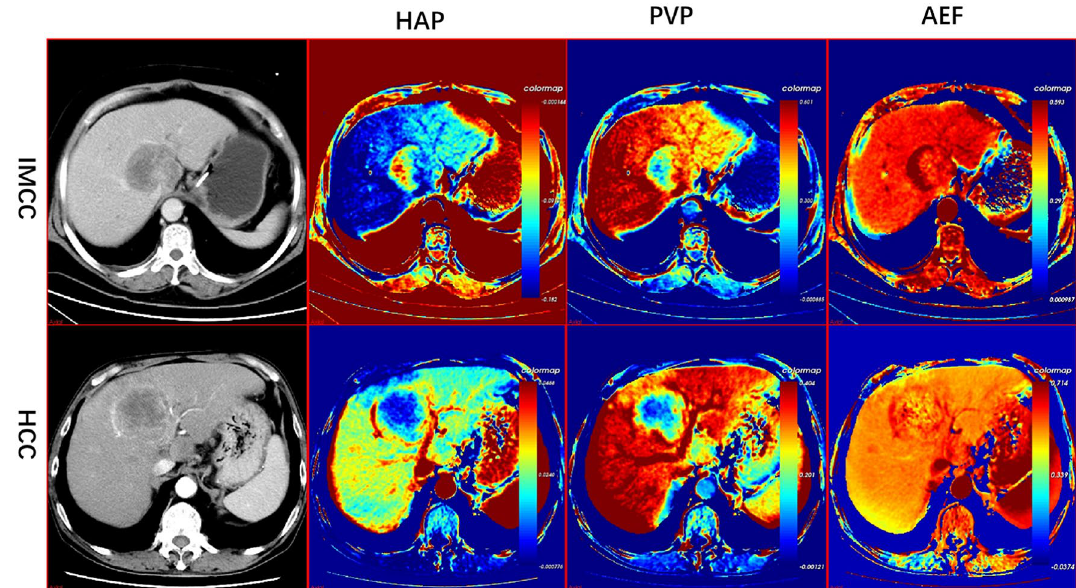
Figure 2. Traditional enhancement image and pharmacokinetic images of IMCC and HCC. For the patients with IMCC, the HAP image showed high perfusion in the margin and relatively low perfusion in the center. PVP images showed hyperperfusion from the peripheral to the central part of the tumor. For patients with HCC, the HAP image showed high perfusion in the rim, while the PVP image showed homogeneous low perfusion in the complete lesion. The AEF images both showed heterogeneous high perfusion for two tumor lesions. HAP Hepatic arterial supply perfusion, PVP Portal venous supply perfusion, AEF Arterial enhancement fraction, IMCC Intrahepatic mass-forming cholangiocarcinoma, HCC Hepatocellular and HCCs are shown in Table 2. Representative CT perfusion images derived from the triphasic CT scans of IMCCs and HCCs are shown in Fig. 2. The AEF mean value, the difference in AEF between tumor and nor- mal liver (ΔAEF = AEF tumor − AEF liver ), and the relative AEF (rAEF = ΔAEF/AEF liver ) were significantly higher in HCCs than in IMCCs ( P ≤ 0.001). The mean value of HAP in patients with HCC was significantly higher than in patients with IMCCs ( P = 0.024). There were no statistical differences in the other perfusion parameters between IMCCs and HCCs ( P > 0.05). The histogram parameters for IMCCs and HCCs are shown in Tables 2 and 3. All of the percentiles of the AEF mean value, ΔAEF, and rAEF were significantly higher in patients with HCCs than with IMCCs ( P < 0.05). The 10th, 25th, 50th, and 75th percentiles of HAP were significantly higher in HCCs than in IMCCs ( P < 0.05). The kurtosis of AEF was higher in patients with HCCs than with IMCCs ( P = 0.033), and the variance of PVP was lower in HCCs than in IMCCs ( P = 0.009). The 25th percentile of HF tumor was significantly higher in patients with HCCs than IMCCs ( P = 0.036). The 10th and 25th percentiles of ∆HF were also higher in HCCs than in IMCCs ( P = 0.011 and 0.030, respectively). For the other histogram parameters, there were no statistically significant differences between the two groups. Differential diagnostic ability of the perfusion parameters and the corresponding histogram parameters for IMCCs and HCCs. ROC curves were used to evaluate the ability of the statistically signifi- cant tumor perfusion parameters and corresponding histogram parameters to discriminate between IMCCs and HCCs. As shown in Figs. 3 and 4, and Table 4, of the mean value of AEF and all corresponding percentiles of the histogram analysis, the 10th percentile of the AEF had the highest value of 0.769. The sensitivity and specificity were also 77.8% and 67.6%, respectively, with a cutoff value of 0.466. The positive predictive value (PPV) and negative predictive value (NPV) were 0.792 and 0.657, respectively. The 25th percentile of the AEF had the high- est sensitivity of85.2%, however, the 50th percentile of the AEF had the highest specificity of70.6%. For the mean value and corresponding percentiles of ΔAEF and rAEF, the 10th percentile of ΔAEF and rAEF had the highest AUC value of 0.788, with the cutoff value of − 0.034 and 0.952, respectively. The mean value, 75th percentile of ΔAEF, and the 75th percentile of rAEF had the highest sensitivity of 94.4%, and the 50th percentile of rAEF had the highest specificity of 82.4%. The 50th percentile of rAEF had the highest PPV value of 0.846, and the mean value of ΔAEF was the highest NPV value at 0.832. For the ∆HAP, the 10th percentile had the highest AUC value of 0.667, with a sensitivity and specificity of 64.8% and 67.6%, respectively. The 75th percentile of ∆HAP had the highest sensitivity of 88.9%, while the 25th and 50th percentile of ∆HAP had the highest specificity of 73.5%. The variance of PVP and the kurtosis of AEF also exhibited a statistical difference between IMCCs and HCCs, with AUCs of 0.665 and 0.636, respectively. The 25th percentile of HF tumor , and the 10th and 25th percentiles of ∆HF exhibited AUCs of 0.602, 0.638, and 0.606, respectively. The 25th percentile of HF had the highest sensitivity of 94.4%.